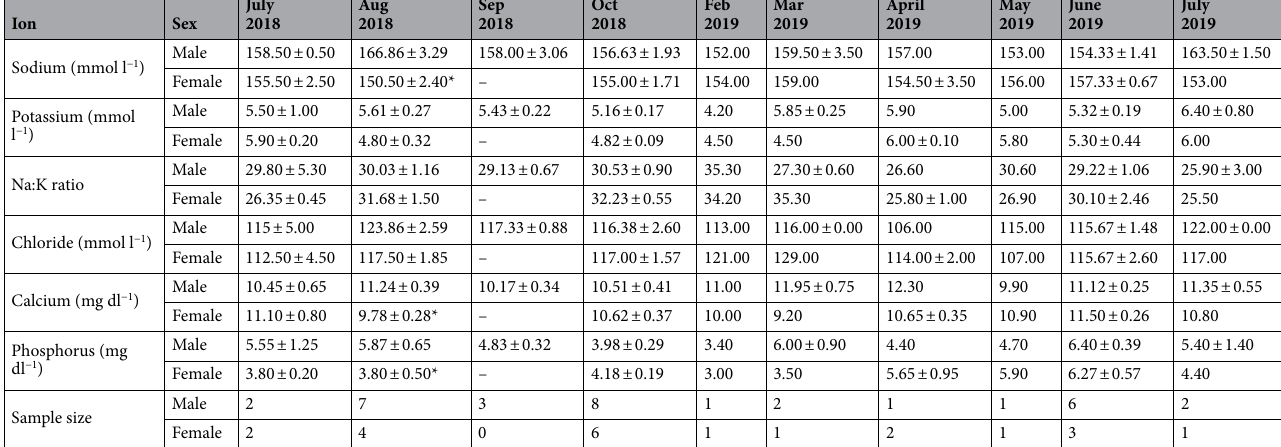
Table 1. Plasma ion concentrations in juvenile American alligators ( Alligator mississippiensis ) sampled in the wild. *Significant difference between males and females during the indicated month (p < 0.05). Values shown are averages ± SEM. SEM is not shown in cases including only one animal.